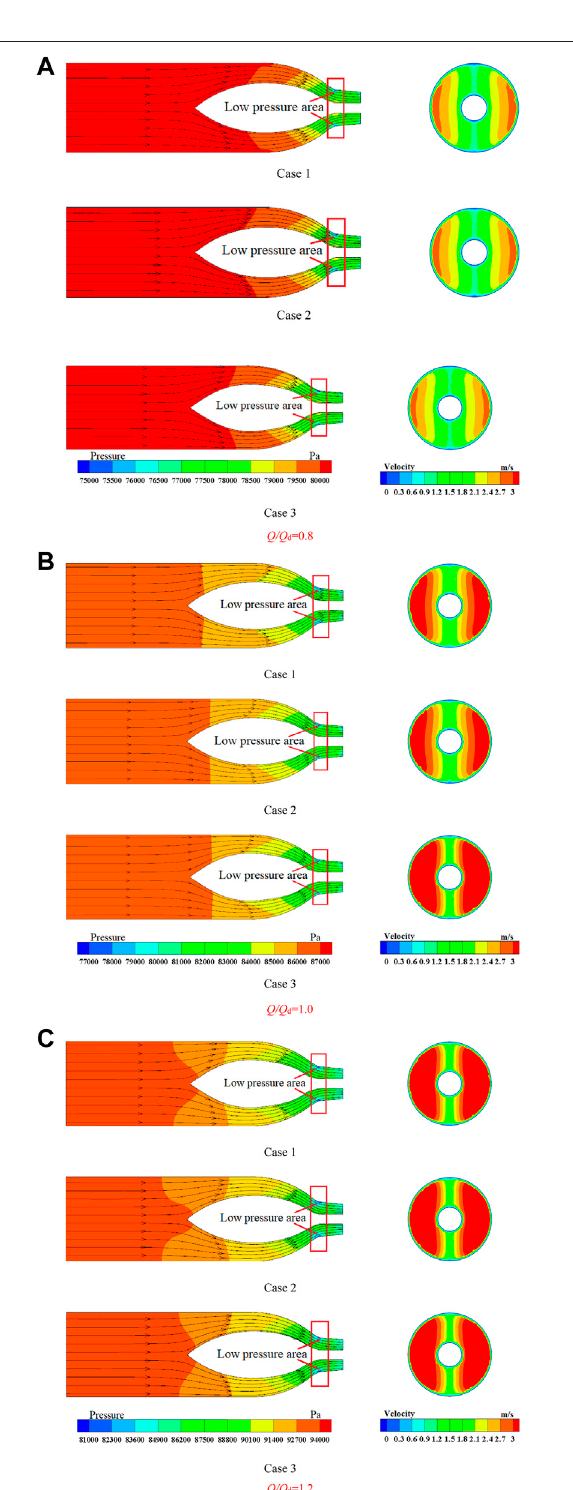
FIGURE 8 | Streamlines and the pressure distribution on the center section (left) and the velocity distribution on section 5-5 (right) of different cases under each condition. (A) Q/Q d = 0.8 (B) Q/Q d = 1.0 (C) Q/Q d = 1.2.